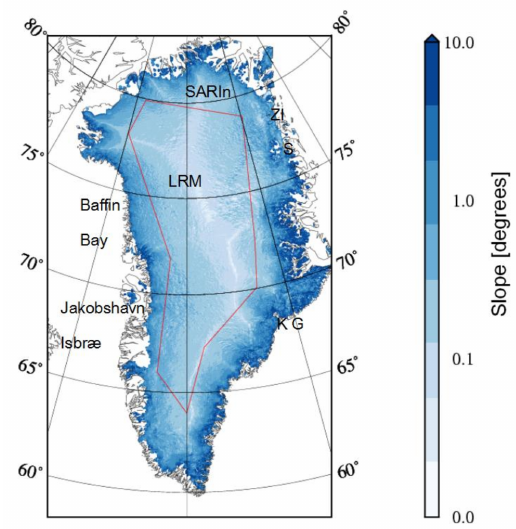
Figure 3. Surface slope of the GrIS derived from the ICESat digital elevation change model (DEM) [31]. The boundary between the Synthetic Aperture Radar Interferometric (SARIn) and Low Resolution Mode (LRM) regions is marked in red based on the division of CryoSat-2 [34]. ZI: Zacharias Isstrømen; KG: Kangerlussuaq Glacier; S: